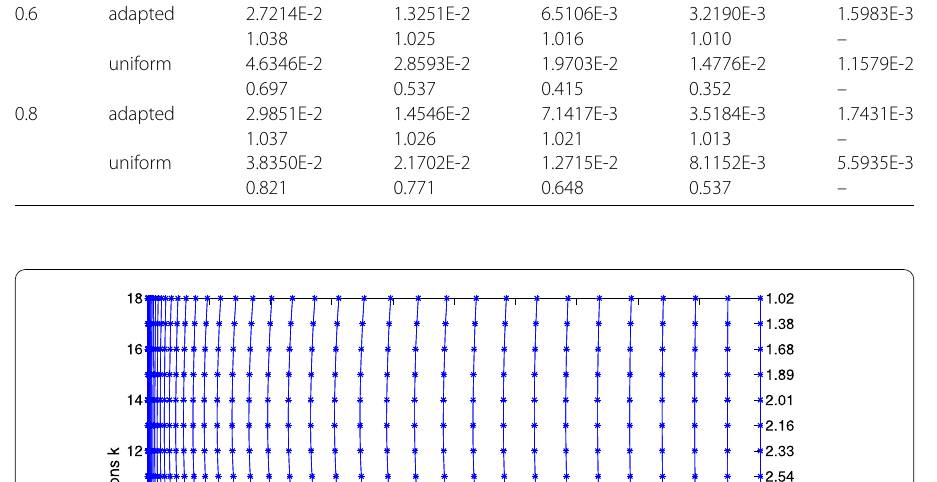
and the convergence rates